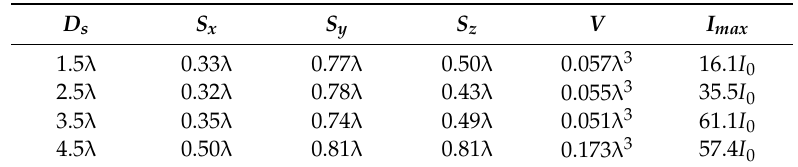
Table 1. Light focusing properties of the microspheres with a fixed refractive index of n = 1.5 and different sphere diameters ( D s ).